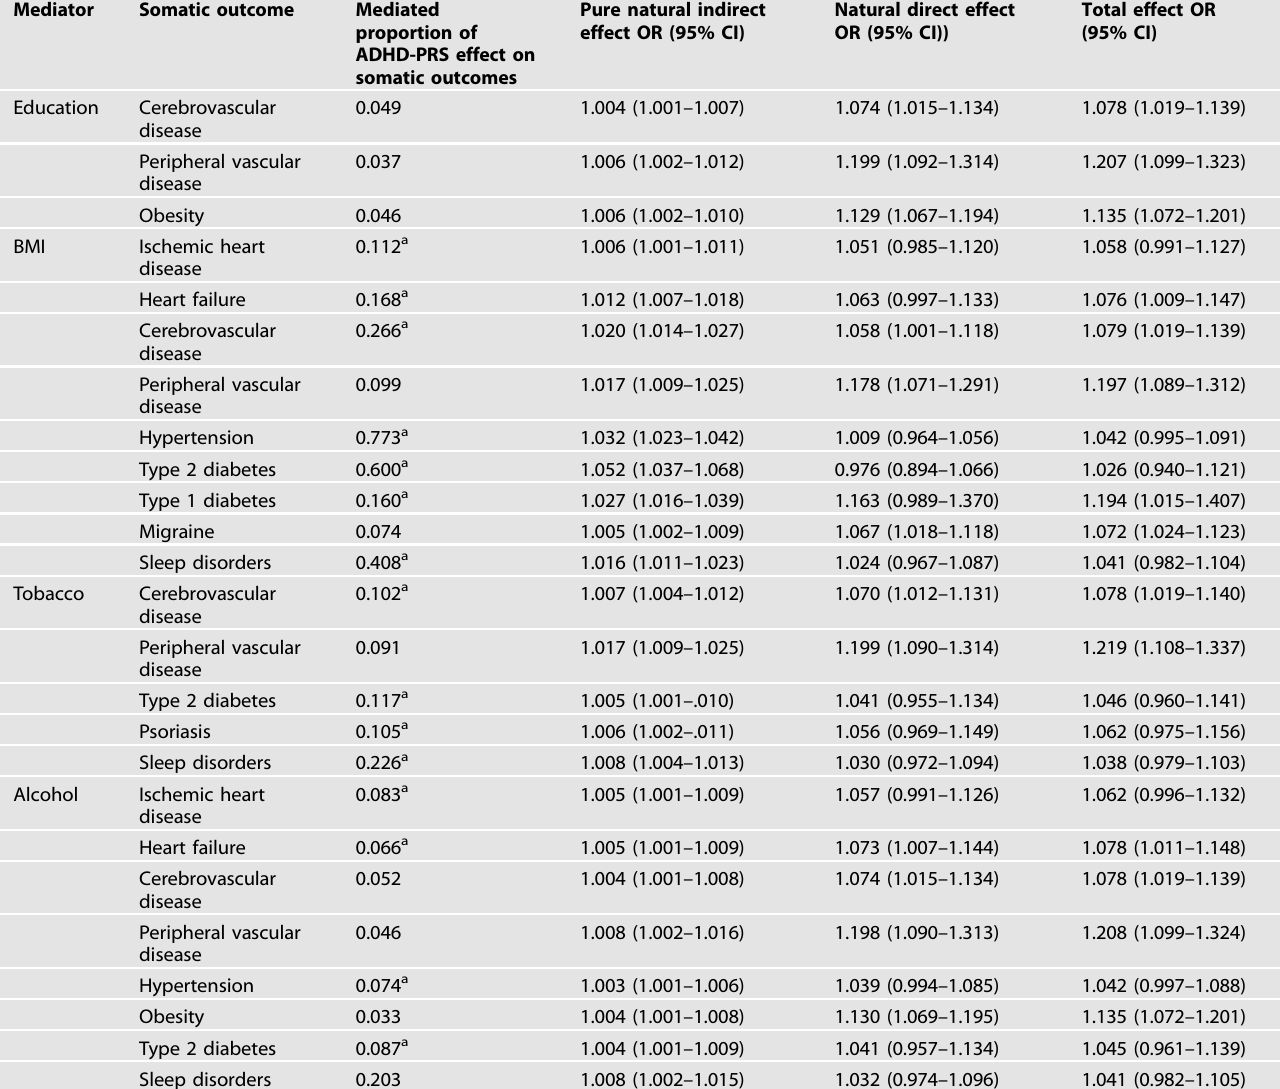
Table 4 present the total effect, pure natural indirect, and natural direct effects, and the proportion mediated (i.e., ratio of the logit for the indirect effect to the logit for the total effect) by each mediator for each somatic health outcome. Associations are expressed as odds ratios together with their 95% CIs and the proportion mediated as the proportion of the total effect that is mediated by each life-style risk factor. BMI was mean centered and treated as a continuous variable. Results are only shown here for mediation effects (i.e., the pure natural indirect effect) that remained signi fi cant ( p < 0.05) after false-discovery rate correction. Full results for all mediation effects together with FDR-corrected p -values are presented in Table S3. PRS polygenic risk score, OR odds ratio, CI con fi dence interval, p adj, false-discovery rate (FDR) adjusted p -values, BMI body mass index. a Displays full mediation, the remaining effects are partial